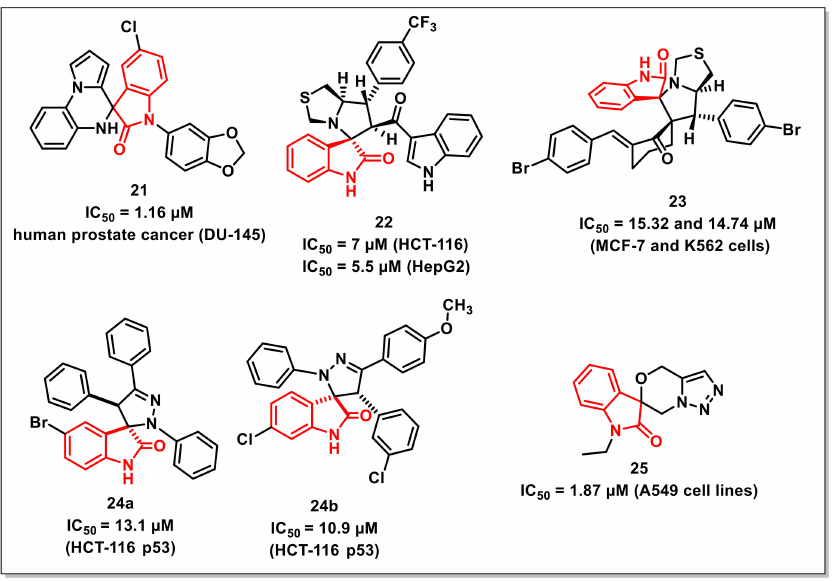
Figure 4. Spiro-isatins as antiproliferative